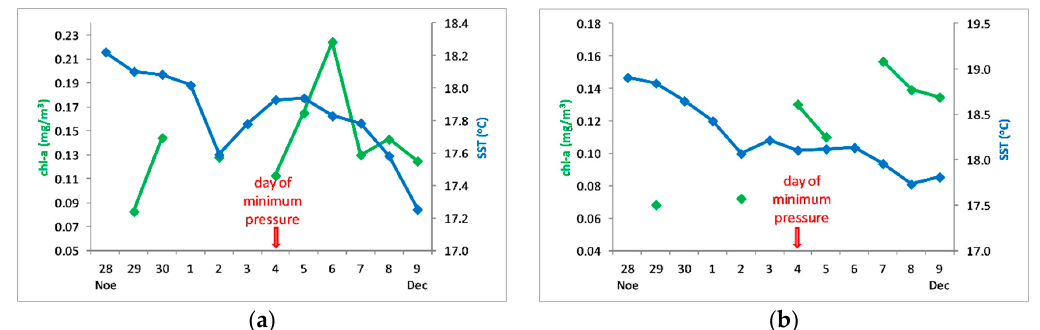
Figure 4. Mean chlorophyll concentration and SST for the time period centered on the event examined ( a ) For the 50 km width area along the cyclone’s track on 14 December 2008; ( b ) For the area of chlorophyll increase marked with P in Figure 3c.